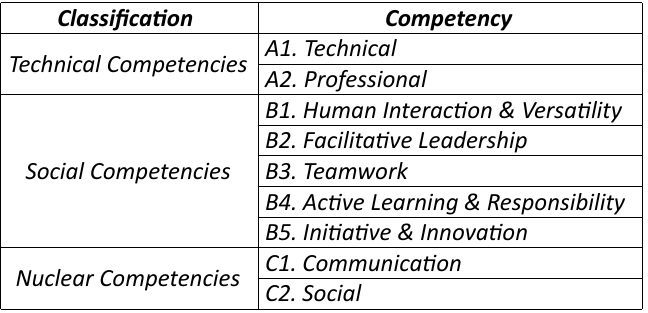
Table 1. Competency dictonary of the